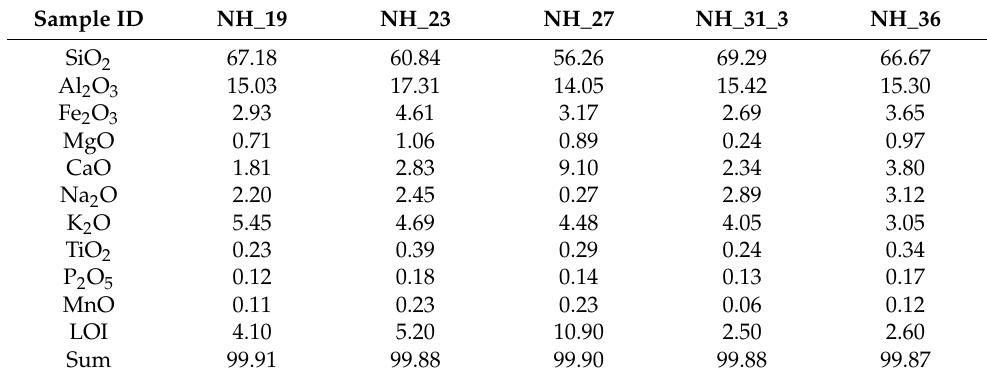
Table 3. Major elements and loss on ignition (LOI) weight percentage (wt%) for the NH